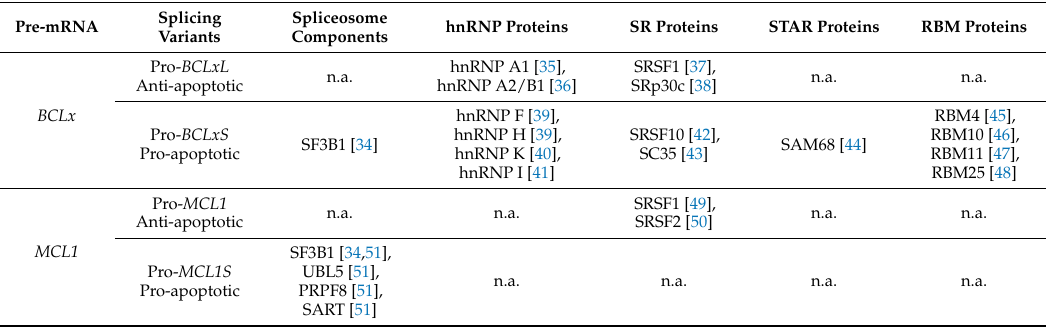
Table 1. RNA binding protein (RBP)-mediated BCLx and MCL1 alternative